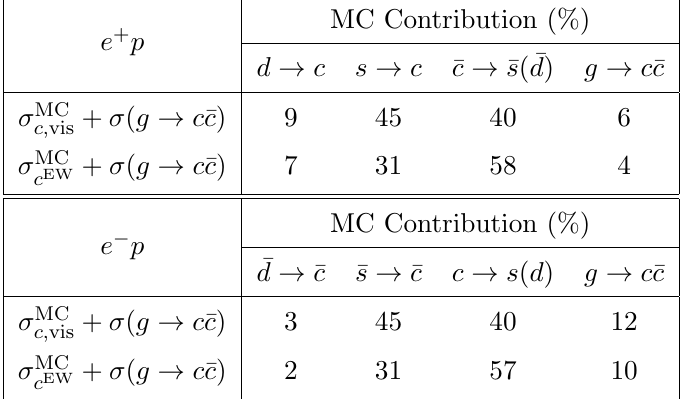
and (cid:27) MC as predicted by ARI- c; vis c EW